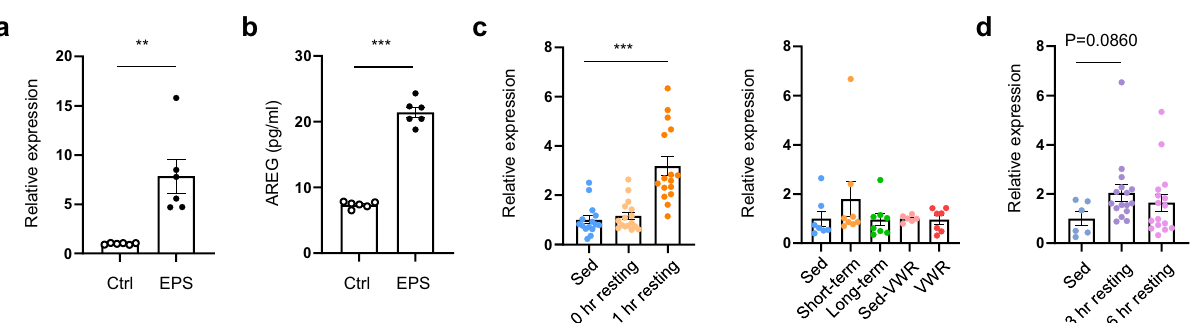
Figure 4. Areg, a candidate myokine biomarker, is up-regulated in EPS and acute maximally exercised muscles. ( a ) Areg expression in C2C12 myotubes after applying EPS for 24 h (n = 6). ( b ) Areg level in medium from C2C12 myotubes after applying EPS for 24 h (n = 6). ( c ) Areg expression in exercised muscles. For acute maximal exercise, sed (n = 15), 0 h resting (n = 16), and 1 h resting (n = 16) TA muscles according to the resting time after exercise were analyzed. For chronic exercise, sed (n = 7), short-term (n = 8), and long-term (n = 8) GA muscles were analyzed. For VWR exercise, sed-VWR (n = 6) and VWR (n = 7) GA muscles were analyzed. ( d ) Areg expression 3 and 6 h after acute maximal exercise. TA muscles from Sed (n = 6), 3 h resting (n = 16), 6 h resting (n = 16) mice were analyzed. Means ± SEM; ** P < 0.01, *** P <